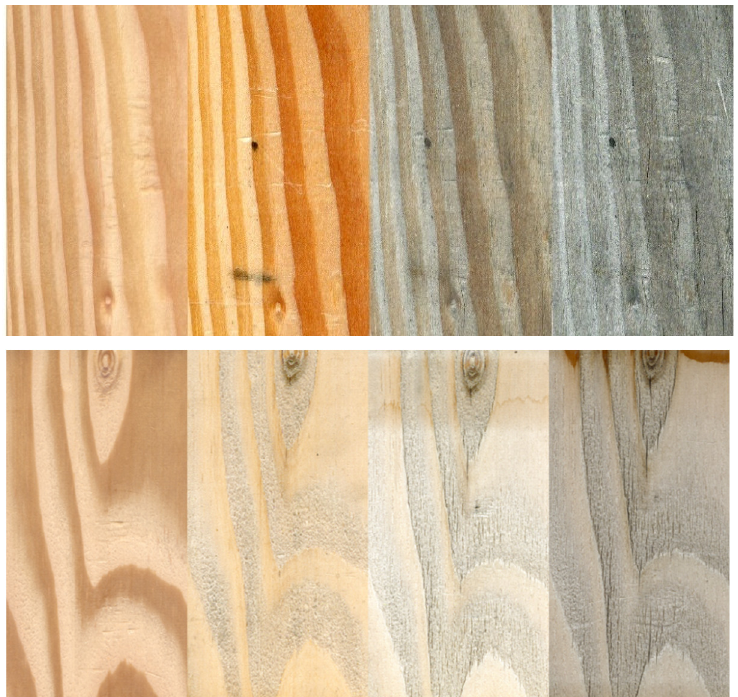
Figure 7. Examples of the same Douglas fir wood specimen treated with HN and exposed outdoors on a test fence near Corvallis, OR, for 0, 6, 12, and 18 months ( top row ) and a similarly treated sample exposed at Madras, OR, for 0, 6, 15, and 25 months ( bottom row ).